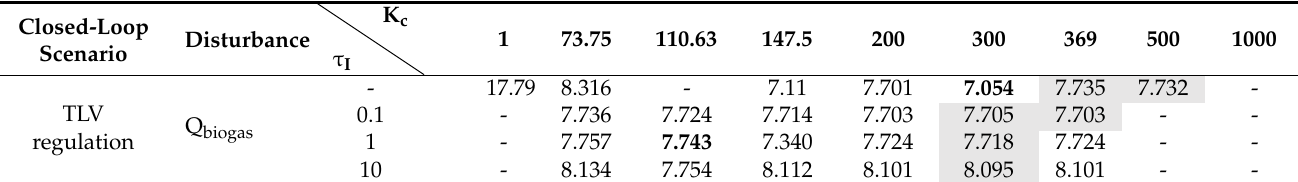
Table 7. IAE criteria result for the TLV-CL when biogas flowrate is the disturbance of the system. Biogas flowrate was step-wise changed corresponding to an Empty Bed Residence Time (EBRT) decrease from 118 s to 48.4 s. Values in bold represent the selected parameters and values shaded in gray provided an oscillatory response of the final control element.